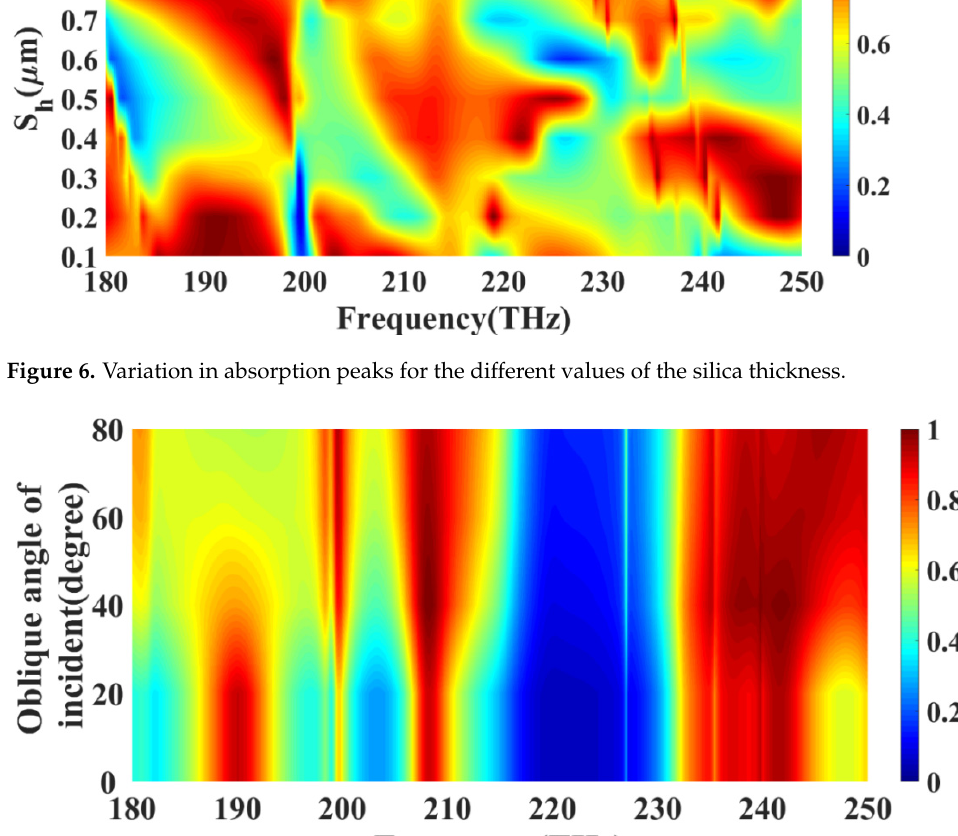
Figure 6. Variation in absorption peaks for the different values of the silica thickness. Figure 7. Effect of the oblique angle on the incident on the absorption values. The oblique angle varies from 0° to 80°.